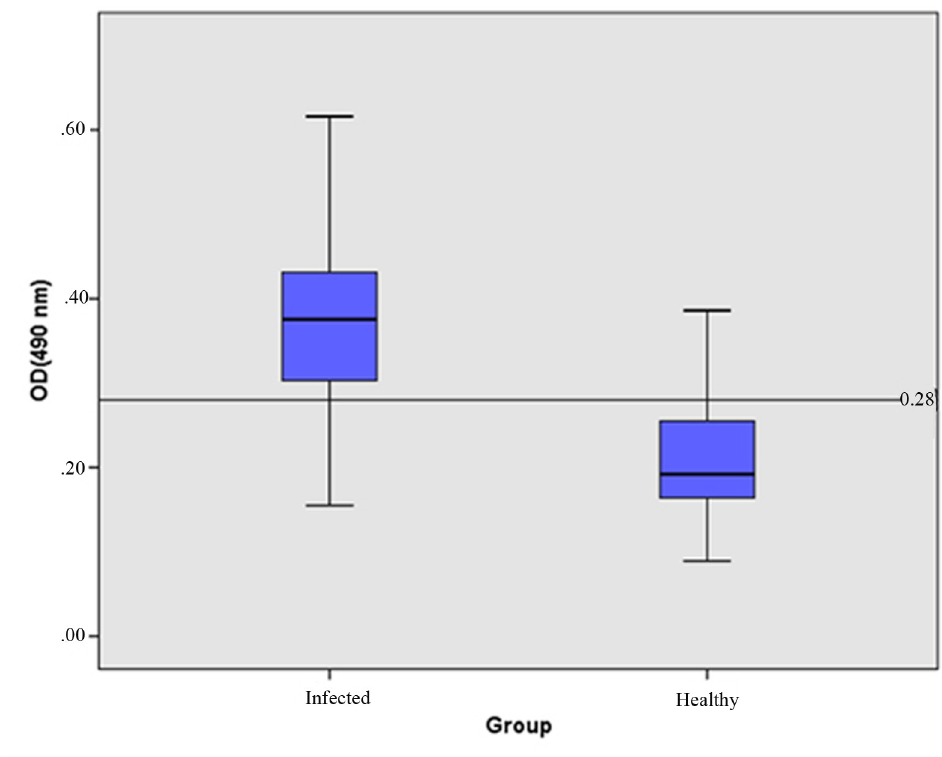
Fig 1. Indirect ELISA responses (OD 490 ) of coconut samples symptomatic for WCLWD (N = 197) and of symptomless, apparently healthy coconut samples (N = 192). Standard box-plots with median, 25 th and 75 th percentiles and whiskers at maximum and minimum values are indicated. The horizontal line at y = 0.28 denotes the cut off value. � p < 0.05.